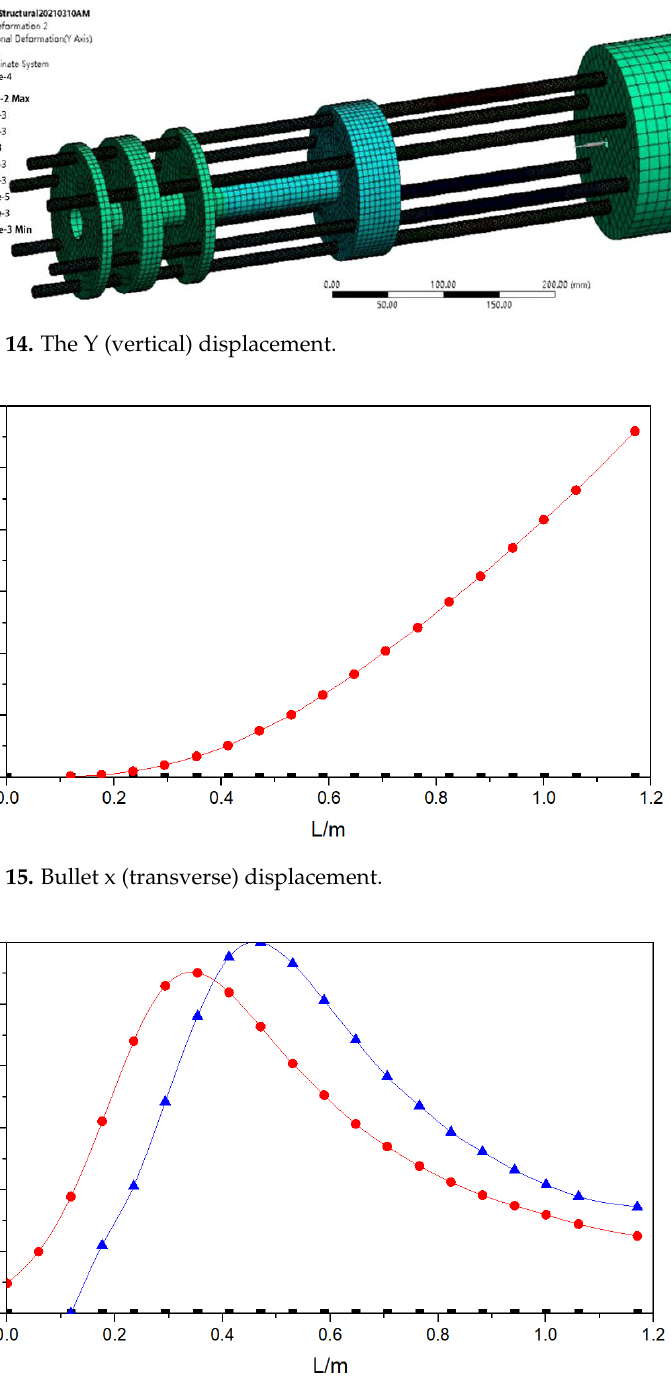
Figure 16. Bullet’s force F1 and Figure 16. Bullet’ s force F1 and F2. Figure 16. Bullet’ s force F1 and F2.